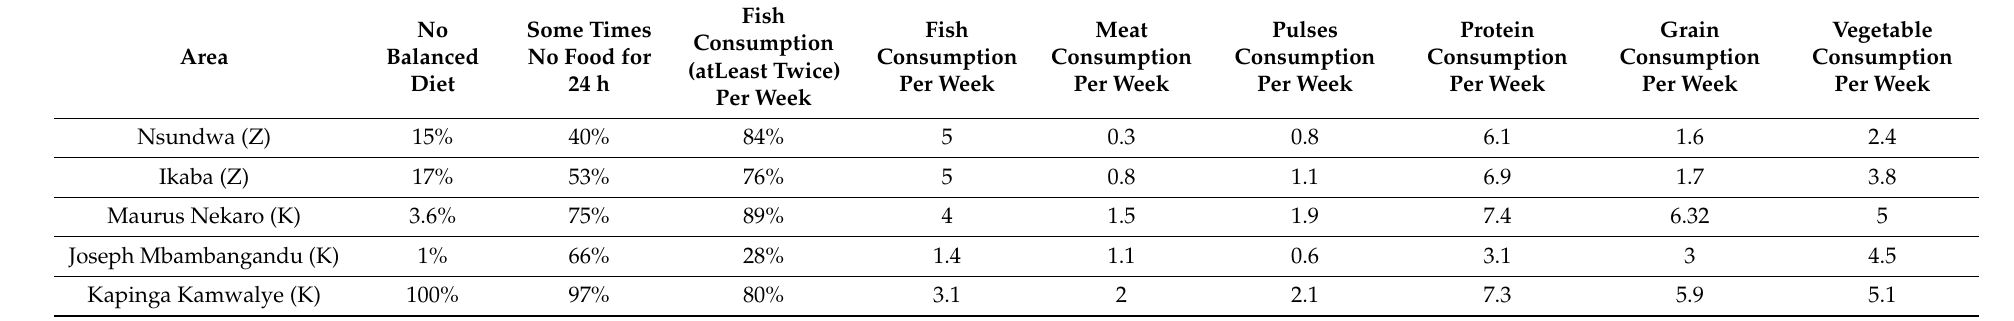
Table 1. Summary results of socio-economic surveys at different sites along the Zambezi and Kavango Rivers. (Z = Zambezi River; K = Kavango